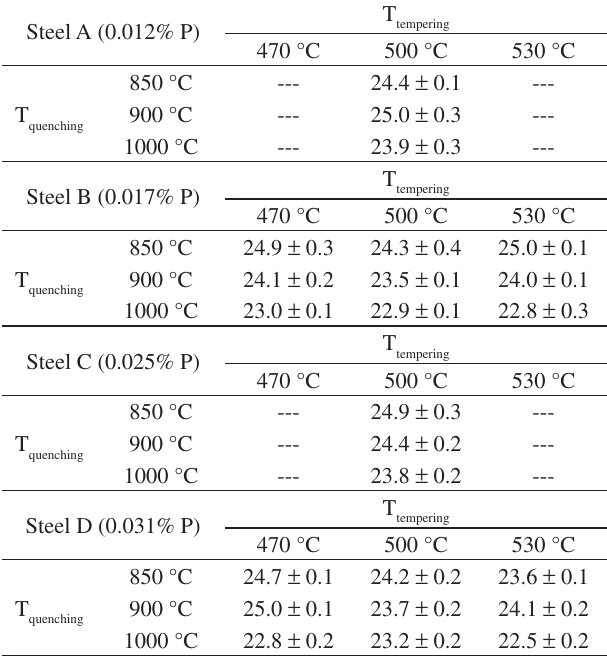
Table 2. Grain size ASTM (μm) for each studied